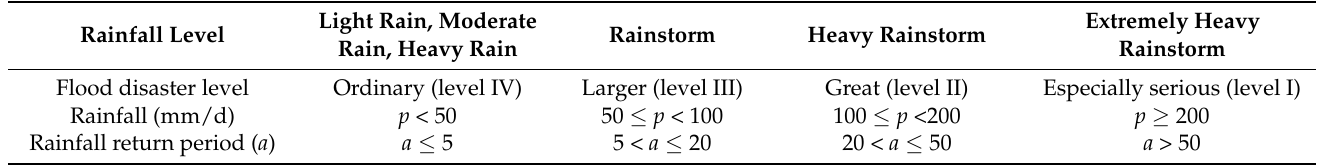
Table 3. Comparison table of grades of rainfall and flood disasters. Light Rain, Moderate Rainfall Level Rainstorm Heavy Rainstorm Rain, Heavy Rain